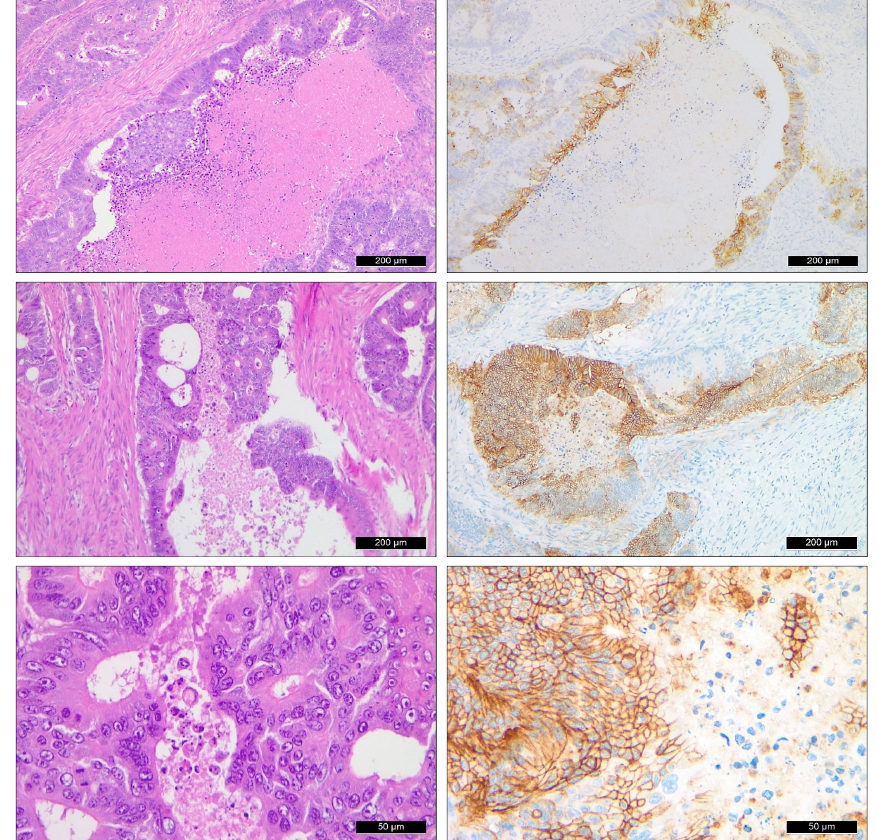
Figure 1. CAIX expression pattern in rectal adenocarcinoma. Conventional HE staining ( left , 10 × ) and CAIX immunostaining ( right ) of equivalent tumor areas presenting selective cell membrane staining. CAIX expression was predominantly found in association with necrotic tumor areas with variable heterogeneity ( top and middle inserts, 10 × ). Robust membrane labeling in a uniform fashion was seen in some solid areas of the tumor ( bottom row , 40 × ).